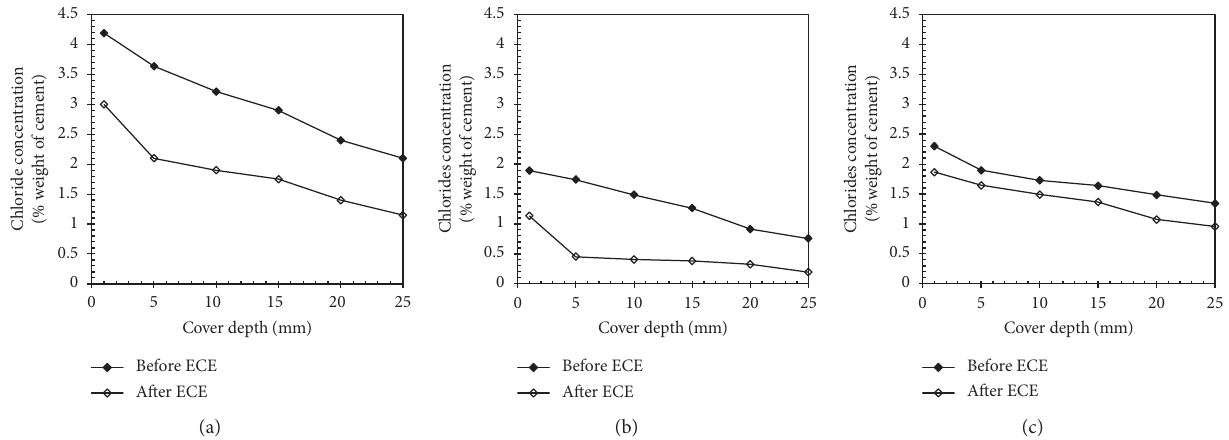
Figure 4: Chloride profiles before and after treatment using water as electrolyte for at 2 A/m 2 constantly for 4 weeks, in terms of (a) total ∗ , (b) free ∗∗ , and (c) bound ∗∗∗ chlorides. ∗ (a) Total: acid soluble titration against silver nitrate at the ambient temperature. ∗∗ (b) Free: water soluble chlorides dissolved in 50 ° C distilled water. ∗∗∗ (c) Bound: values obtained by subtracting the free chloride concentration from the total at each depth.